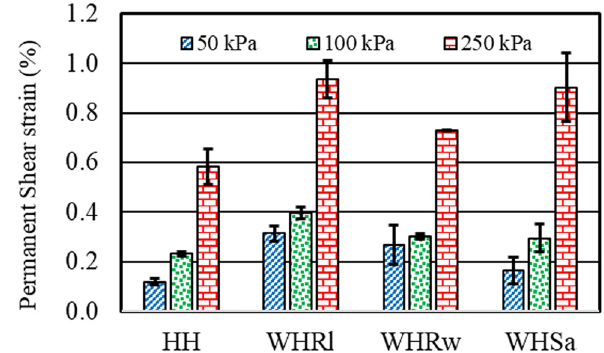
Figure 6: Permanent shear strain at each testing cycle of WMAs manufactured at 135°C.